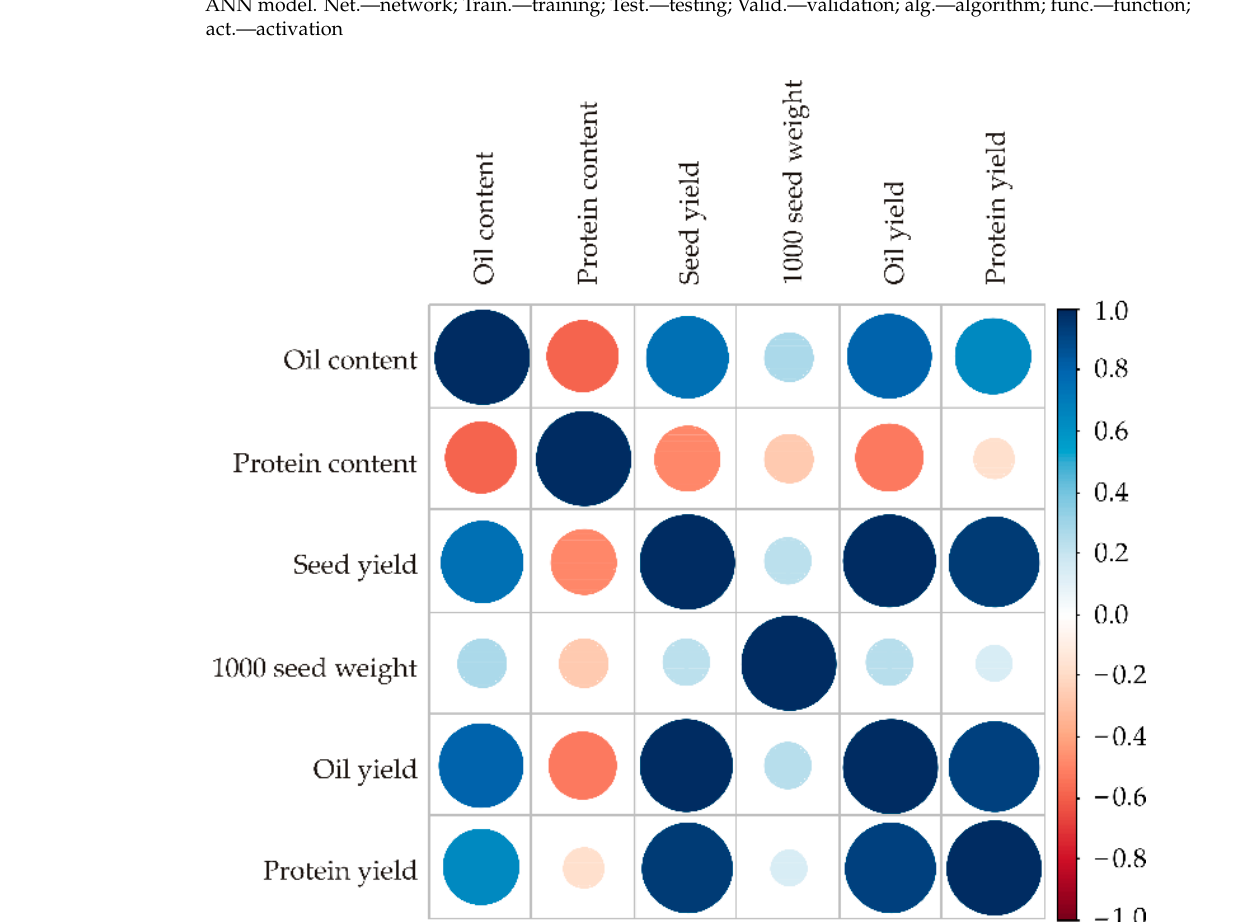
Table 3. Artificial neural network model summary (performance and errors), for training, testing, and validation cycles. Net. Name